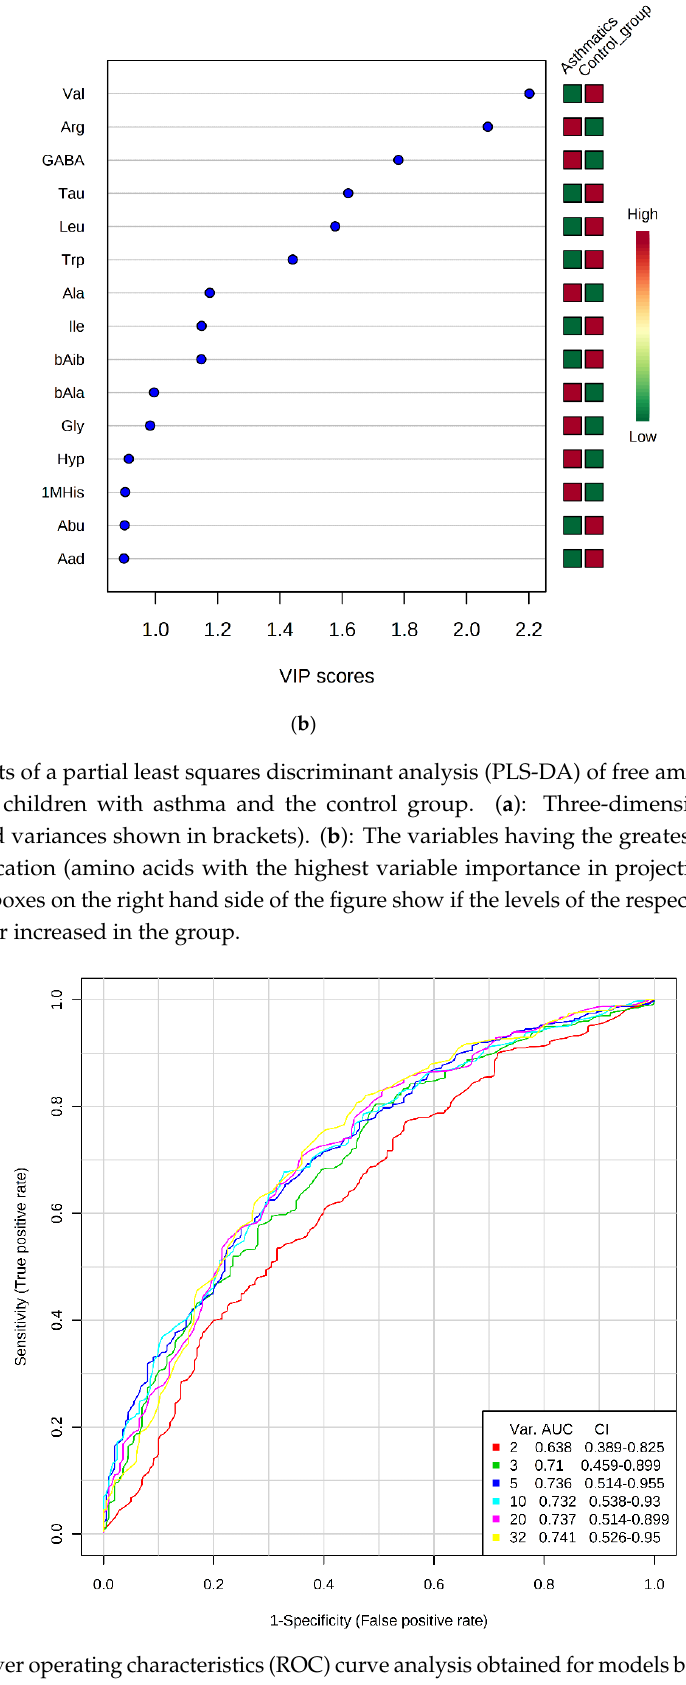
Figure 2. Receiver operating characteristics (ROC) curve analysis obtained for models based on different numbers of variables (serum levels of free amino acids), with area under the curve (AUC) values.